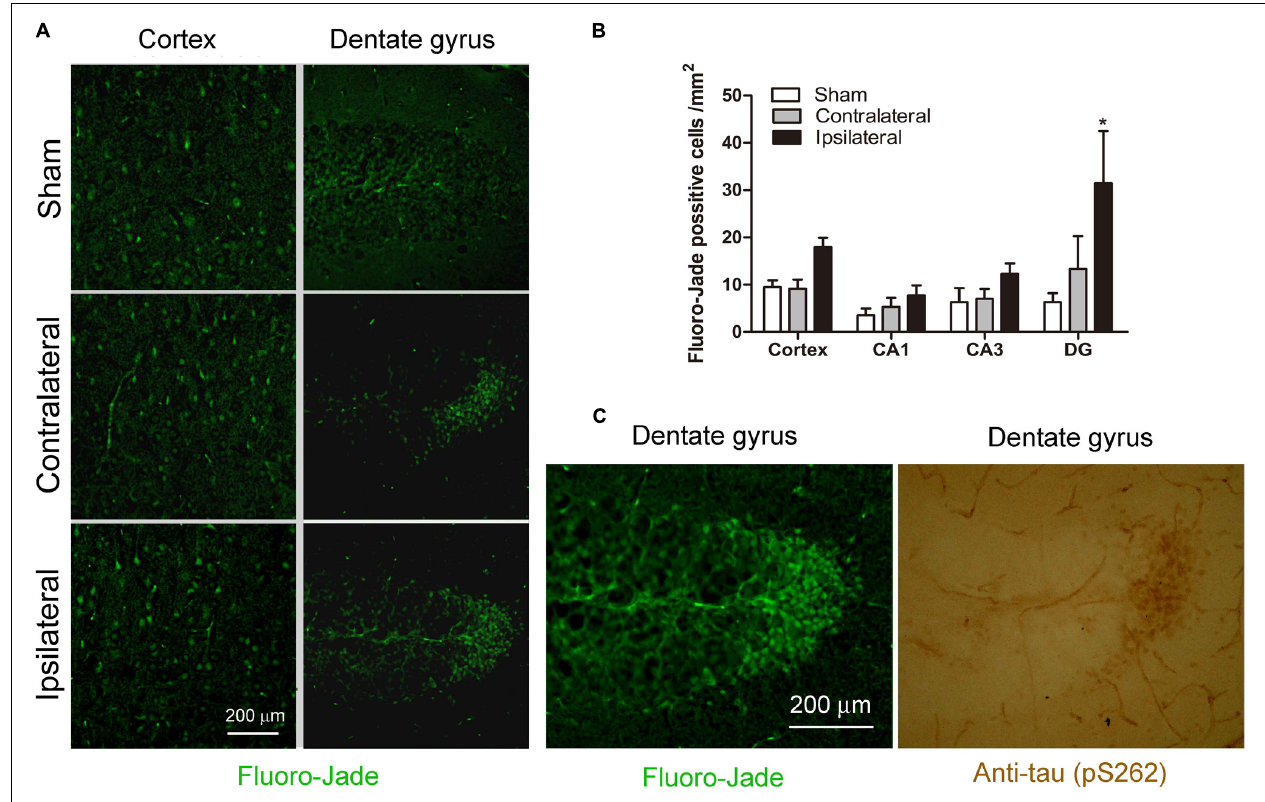
FIGURE 7 | Effects of CCH on neuronal degeneration. Representative microphotographs of Fluoro-Jade stainining of cerebral cortex and dentate gyrus sections of mice 2.5 months after sham or UCCAO surgery (A) .The Fluoro-Jade positive neurons were then quantified by using the Image J